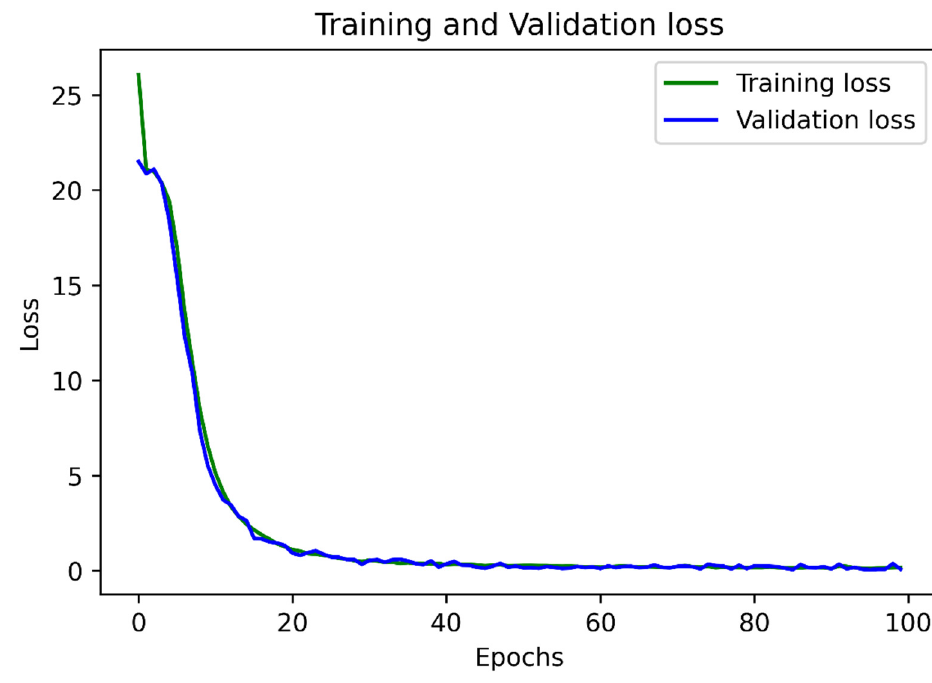
Figure 14. The evolution of both training and validation losses over the first 100 epochs.